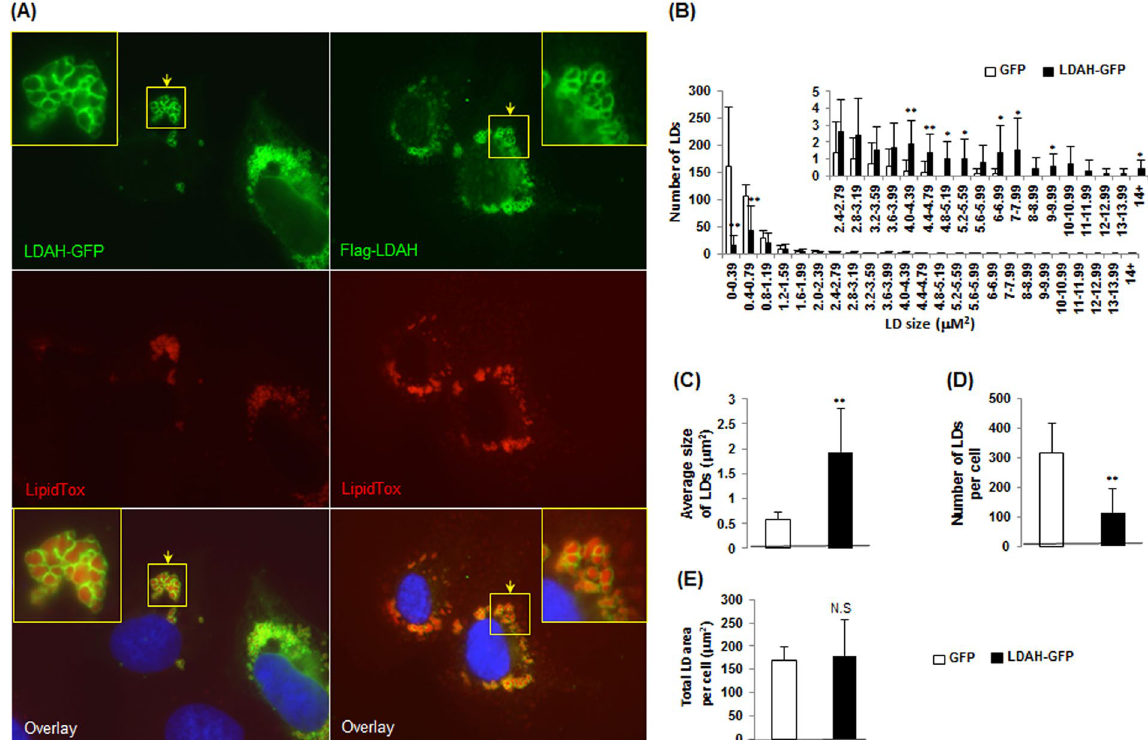
Figure 1. LDAH is a cytosolic protein that localizes to LDs upon OA loading. ( A ) LDAH-GFP (left) or Flag- tagged LDAH (right) were transfected to HeLa cells, and cells were treated with OA (360 μ M for 24 h). Anti-Flag antibody (green) was used to detect Flag-LDAH, and LipidTox (red) was used to stain neural lipids. Nuclei were stained with DAPI (blue). Yellow arrows indicate LDAH associated with merged LDs. ( B – E ) Images of GFP or LDAH-GFP transfected cells loaded with OA were taken by fluorescence microscope and used for morphometric analysis of LDs to determine the effects of LDAH on LD size distribution ( B ); average size of LDs ( C ); average number of LDs per cell ( D ); and total LD area per cell ( E ). Ten cells per group were used for the measurements. * p < 0.05, ** p <